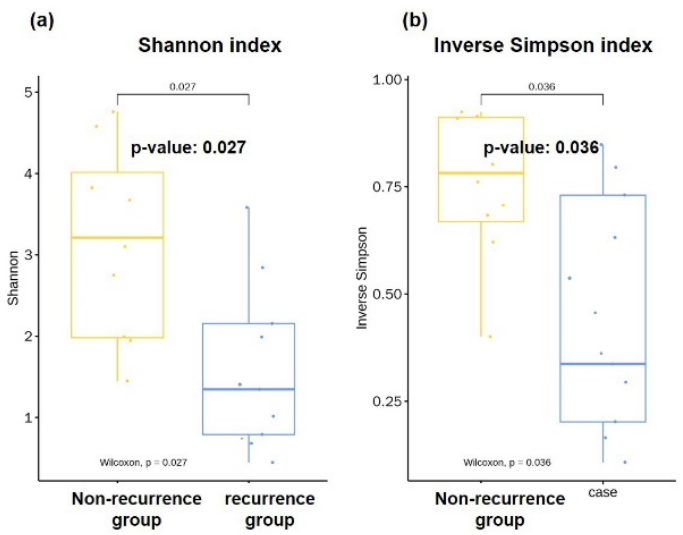
Figure 2. Comparison on evenness and dominance of microbiota in bile. Mean α -diversity, meas- ured by ( a ) Shannon index and ( b ) inverse Simpson index, was reduced in the CBD stone recur- rence group compared to the non-recurrence